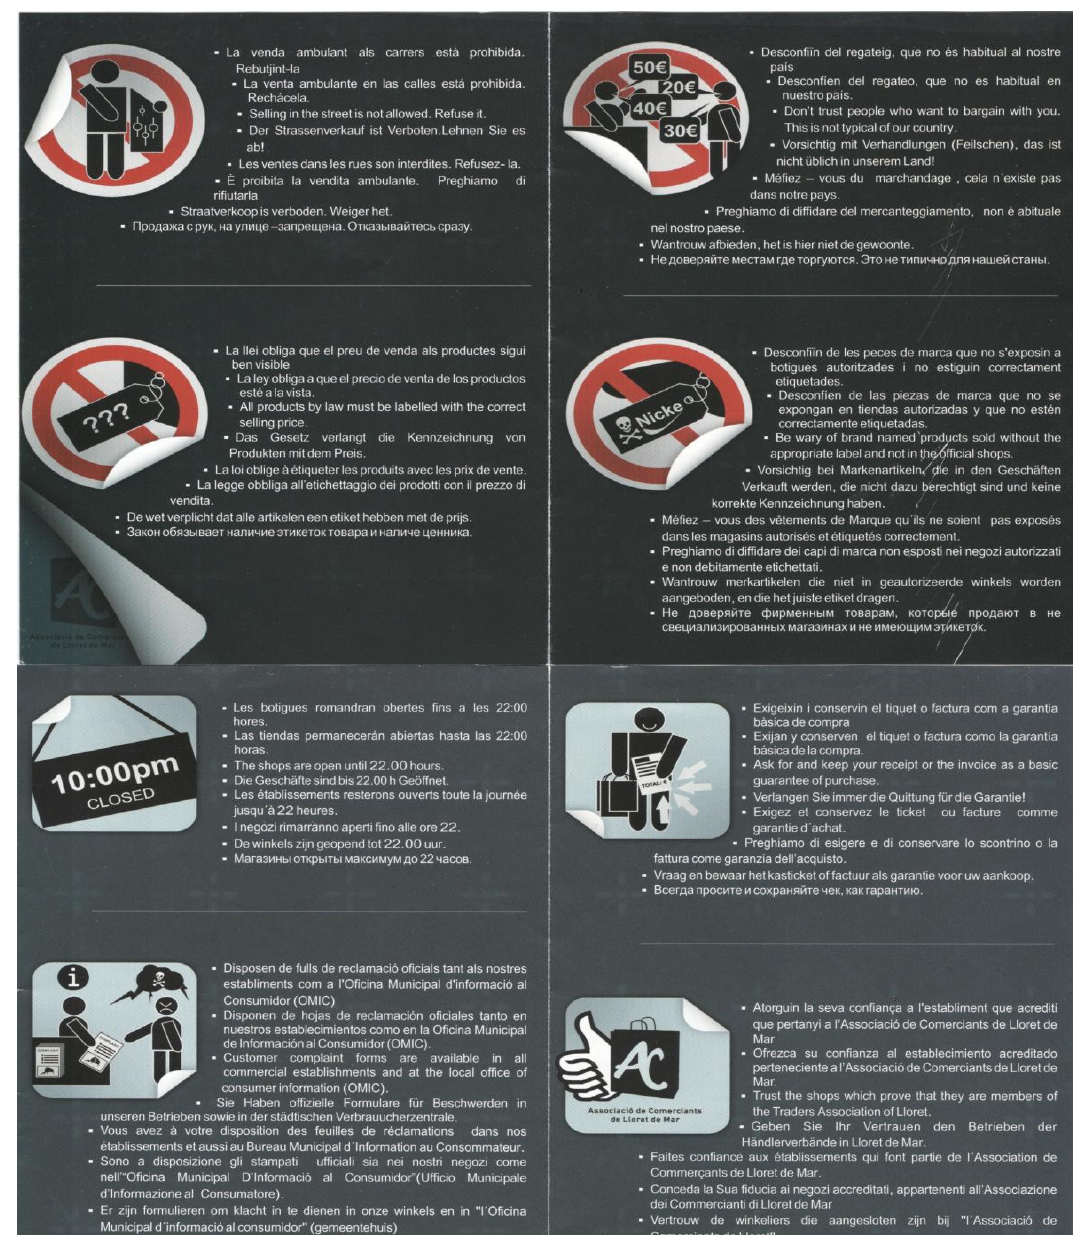
Figure 2. Flyer of the aggressive campaign against unfair competition addressed to the clientele (tourists) in eight languages. The flyers warn about the existence of unlawful activities: informal economy, street hawking, selling of fake goods, etc. , and provides some advices to fight these